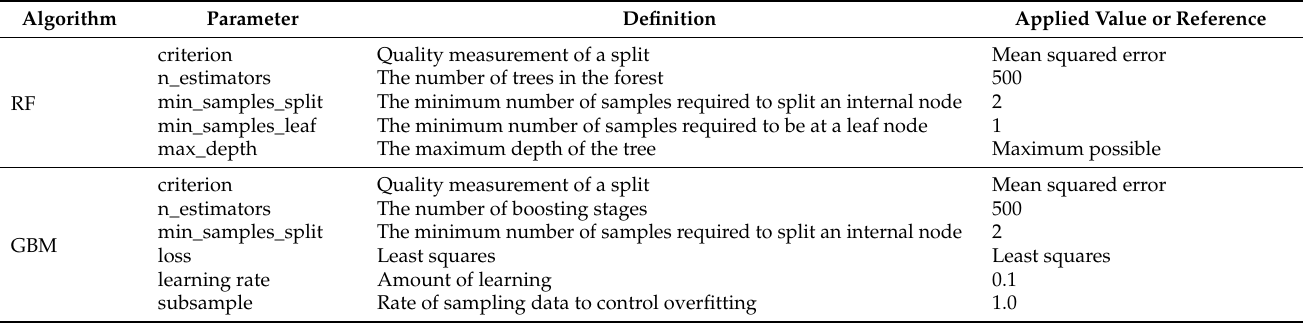
Table 3. Hyperparameters tuned in RF and GBM